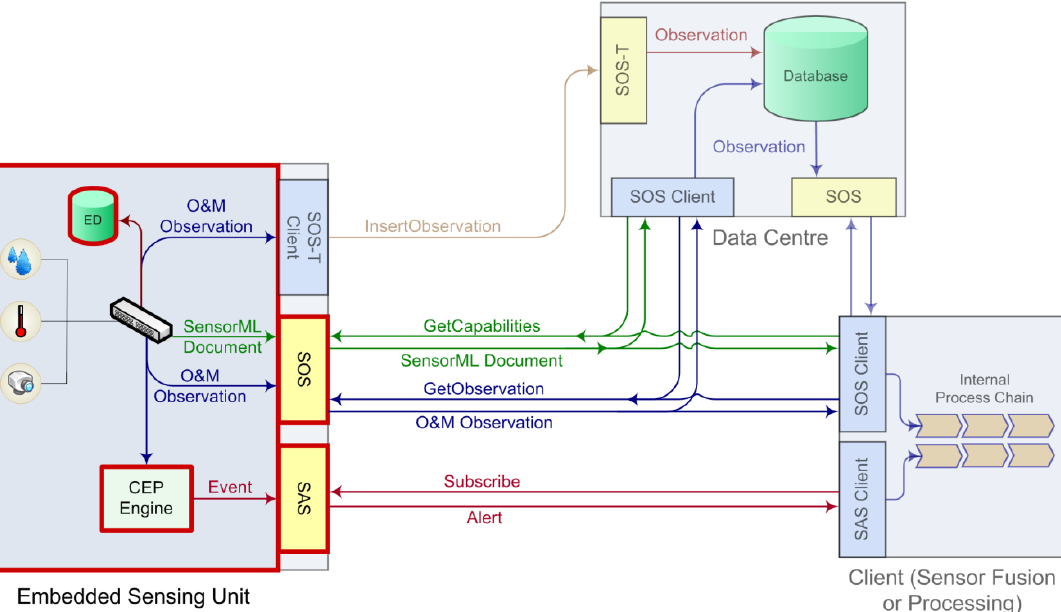
Figure 5. Communication of the Sensor Device with other Components in the